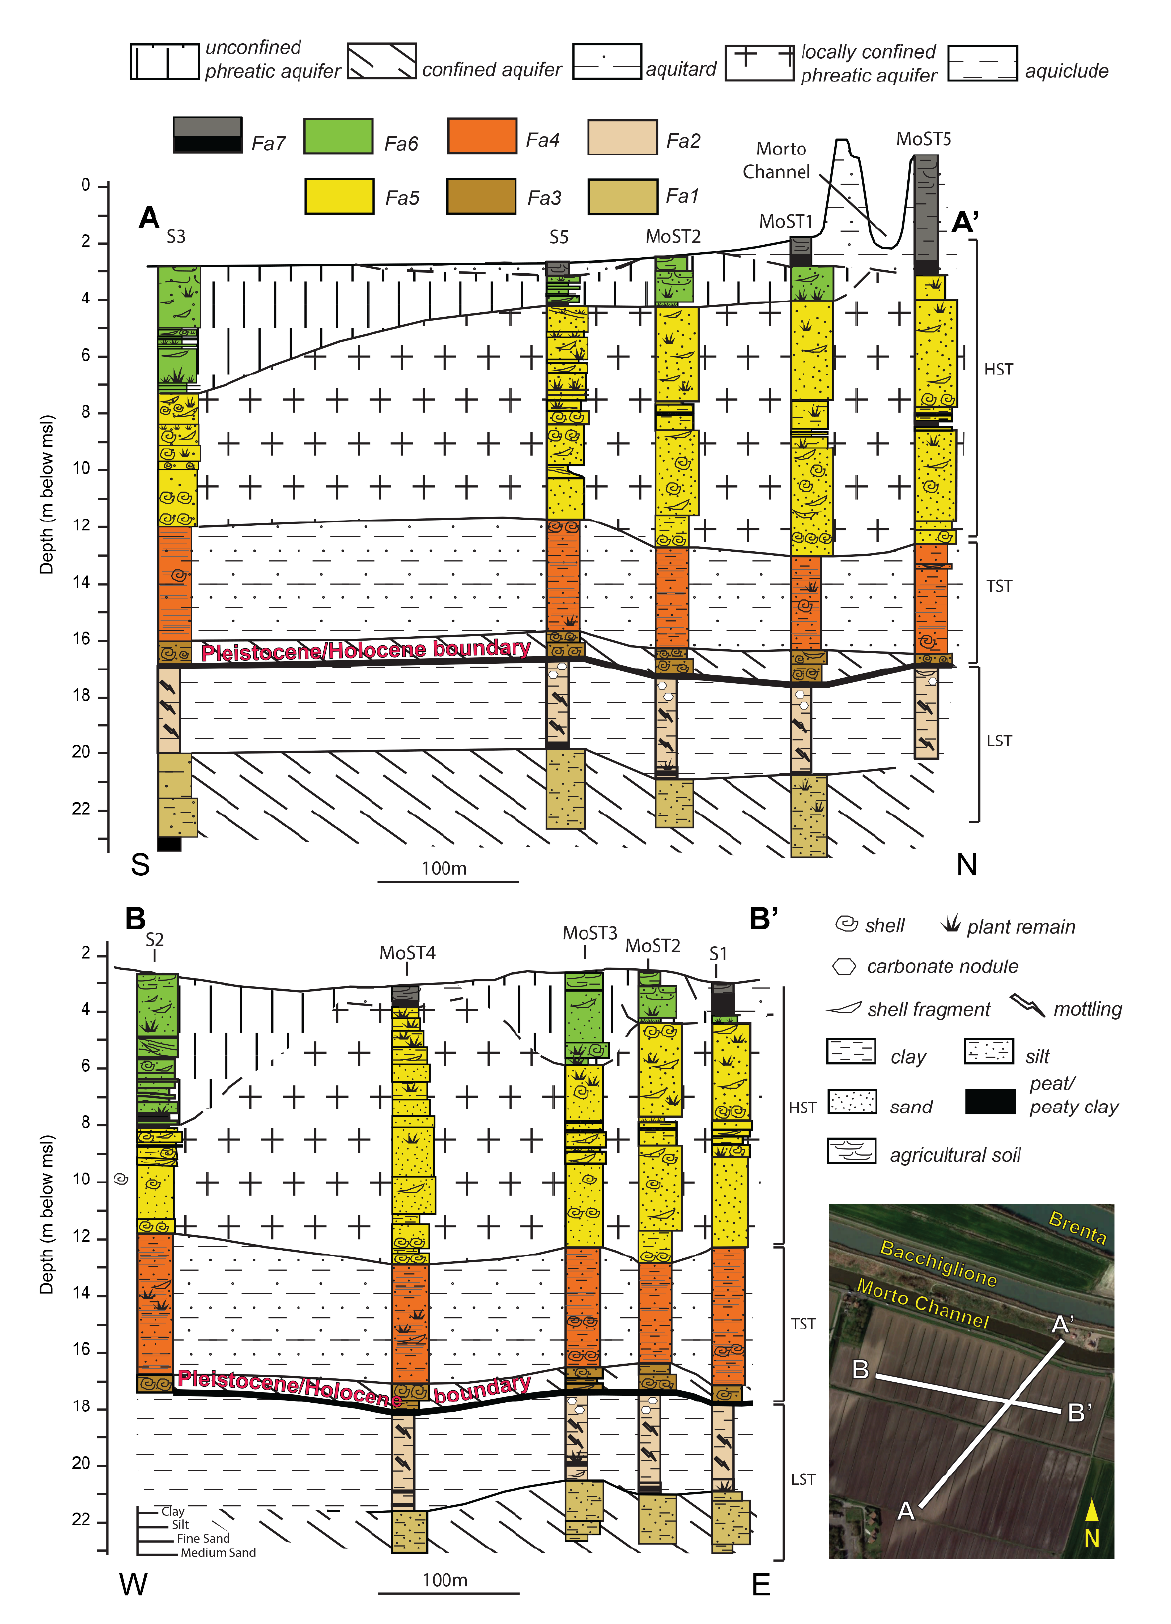
Figure 3. Hydro-stratigraphic sections of the study area (A- A’ and B - B’ in the inset map). Confined Aquifer